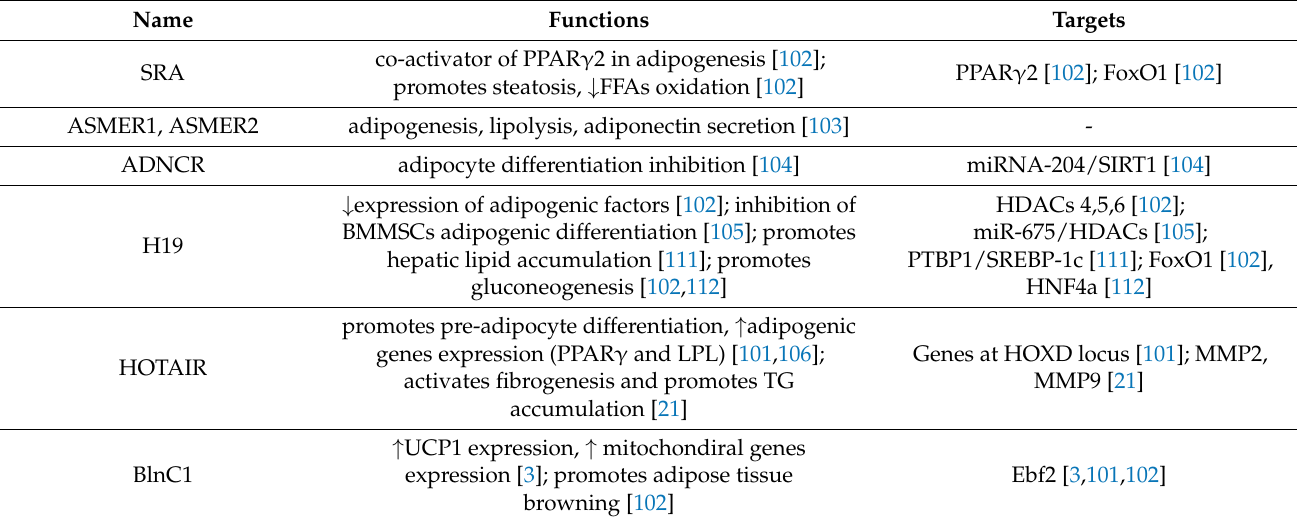
Table 1. Summary of the cited lncRNAs involved in metabolic diseases and their mechanisms of action.